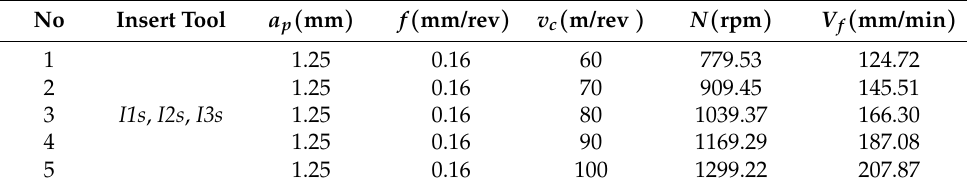
Table 2. Cutting parameters for cutting speed